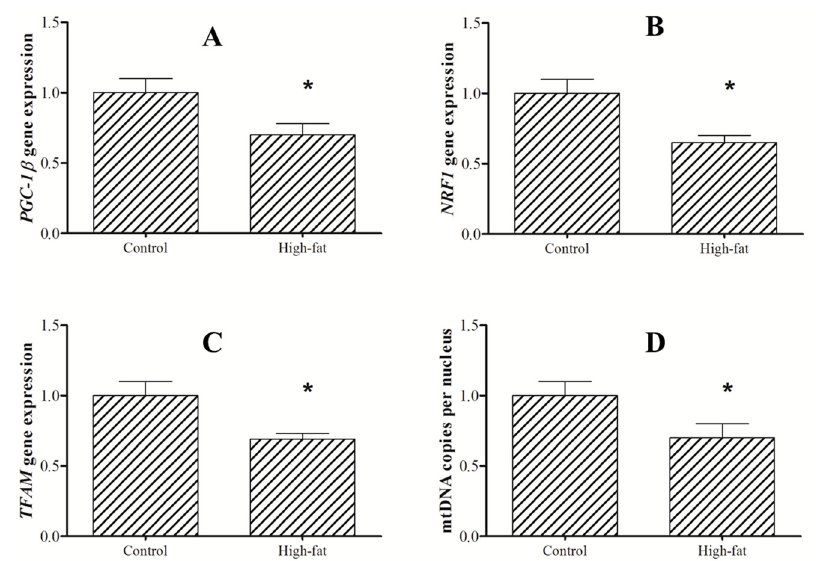
Figure 6. Expression of PGC-1 β ( A ), NRF-1( B ) and TFAM( C ), and mtDNA( D ) copies in liver of